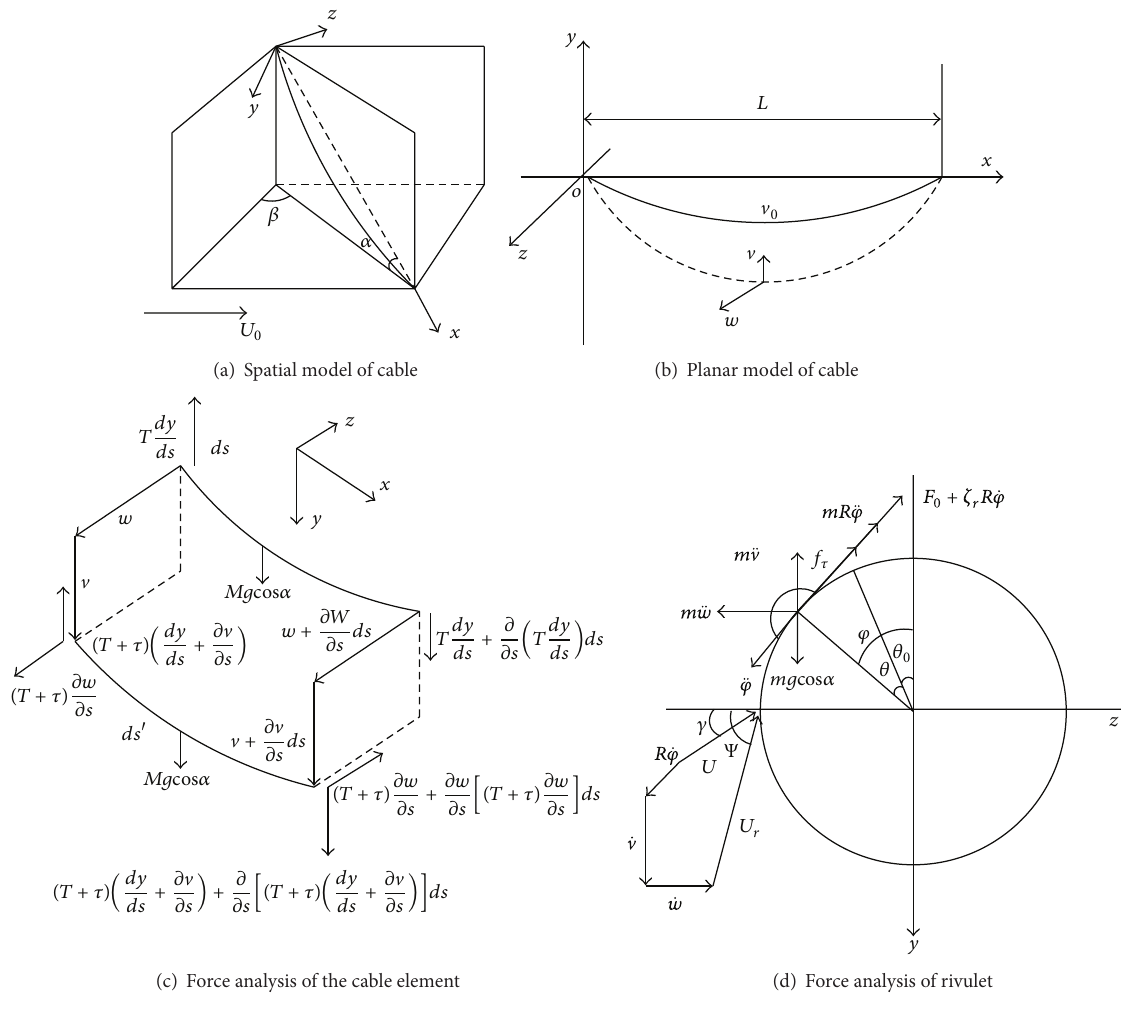
Figure 1: Mechanical model of inclined cable.